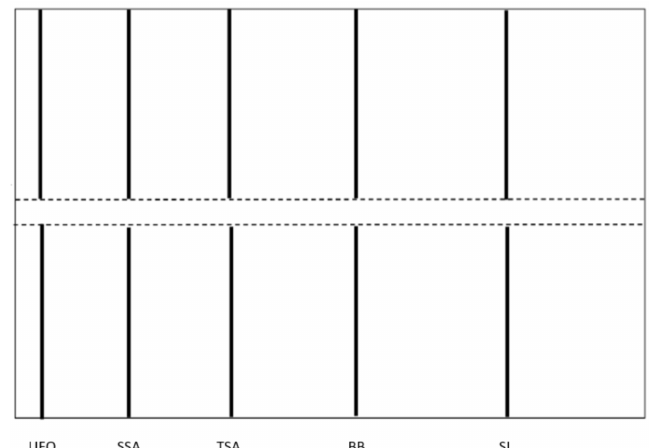
Figure 1. Illustration of the trial block with the five training systems observed for this study split in half by the presence of a walkway. There were rows of trees between the studied rows; however, they consisted of different cultivar, rootstock, age and training system combinations (Approx. 4–6 rows between each of the studied